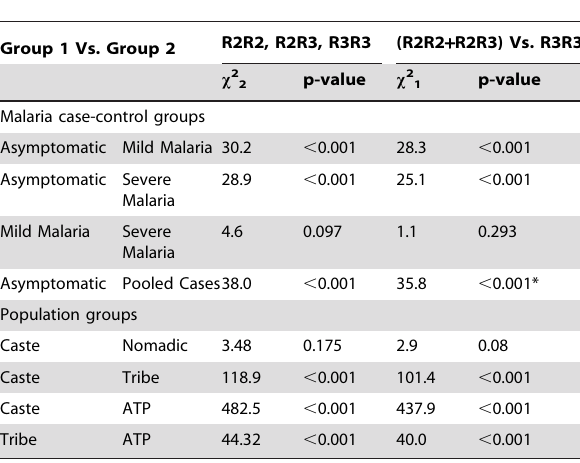
Table 4. Genotype comparison among various groups of malaria case control and population study in multiple